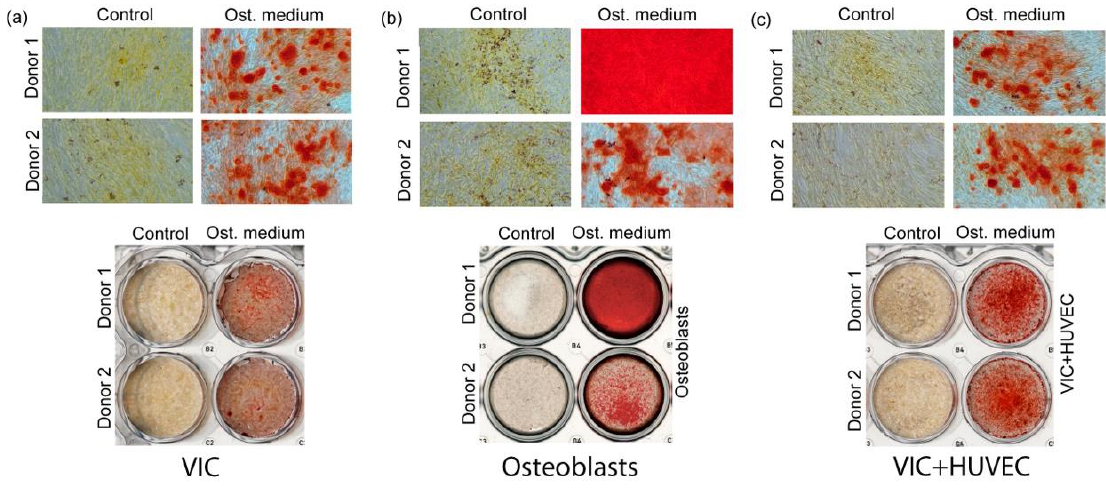
Figure 1. Microscopic images of alizarin-red staining of cells after osteogenic differentiation; calcium depositions are stained in red. Valve interstitial cells (VIC) ( a ), osteoblasts ( b ) and VIC co-cultivated with human umbilical cord endothelial cells (HUVEC) (c) before and after osteogenic differentia-